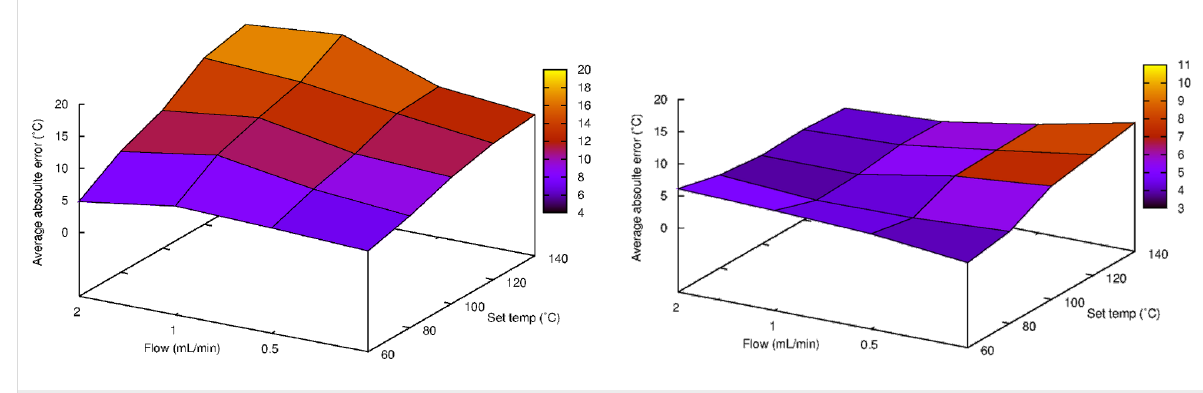
Figure 3: Average absolute errors in measurements for IR sensor 1 (left) and IR sensor 2 (right) plotted against flow and set temperature.